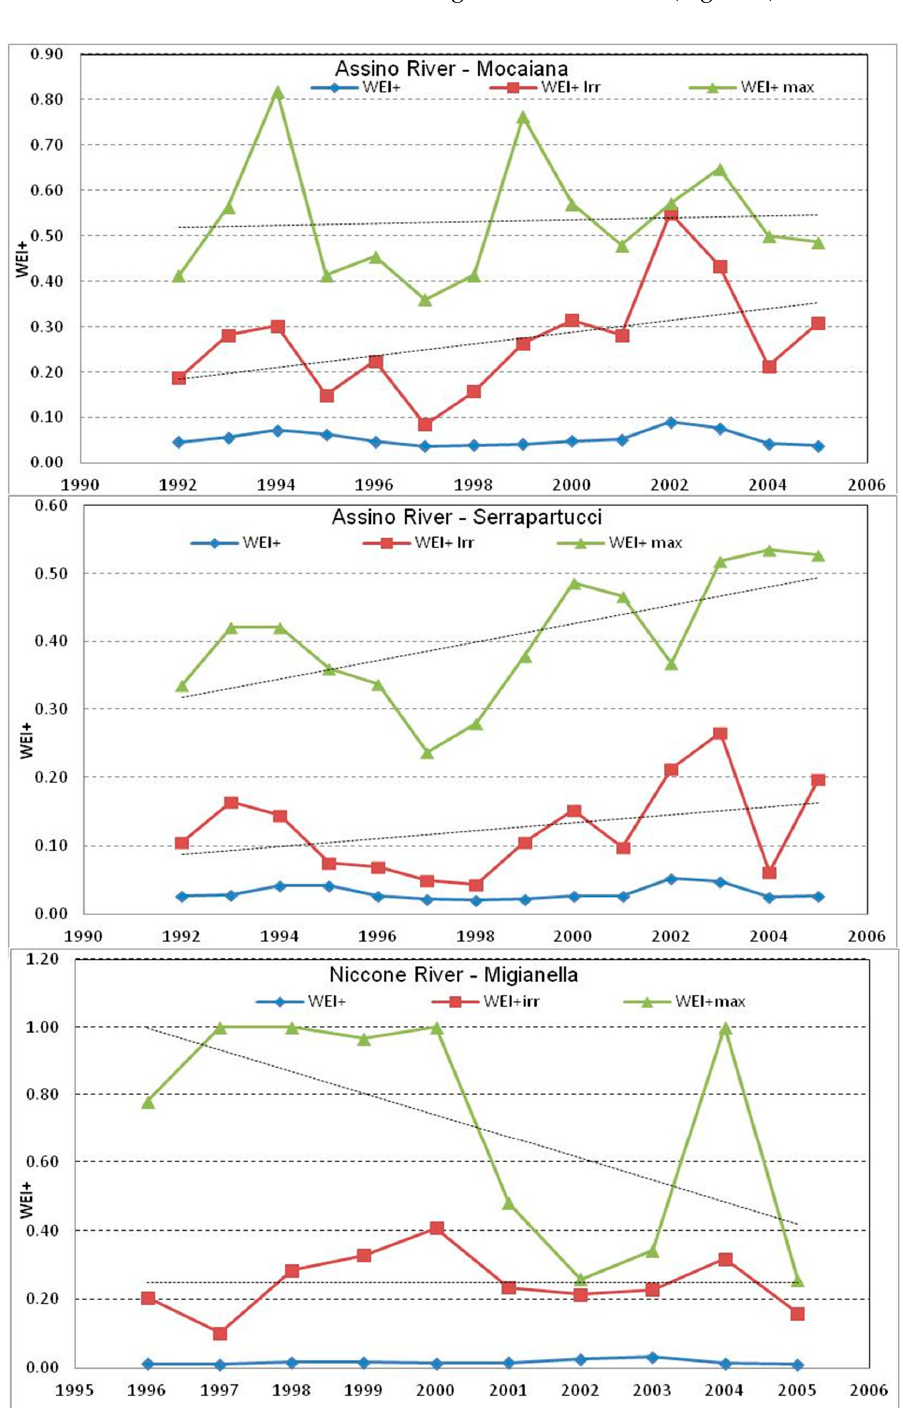
Figure 7. Variability and trend of annual WEI + calculated with the European Commission (EC) method.